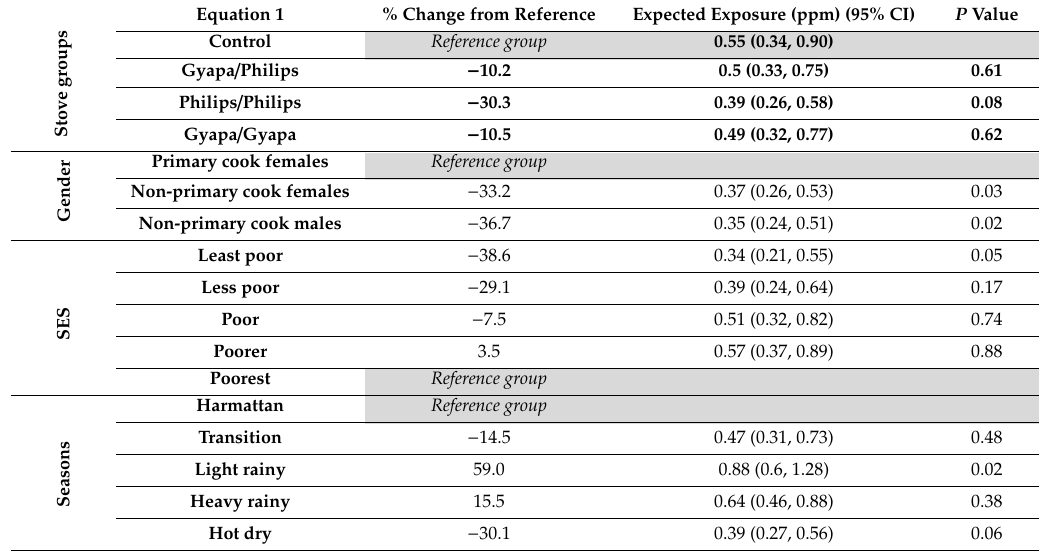
Table 2. Personal CO 24 h average exposure Model 1 results and summary